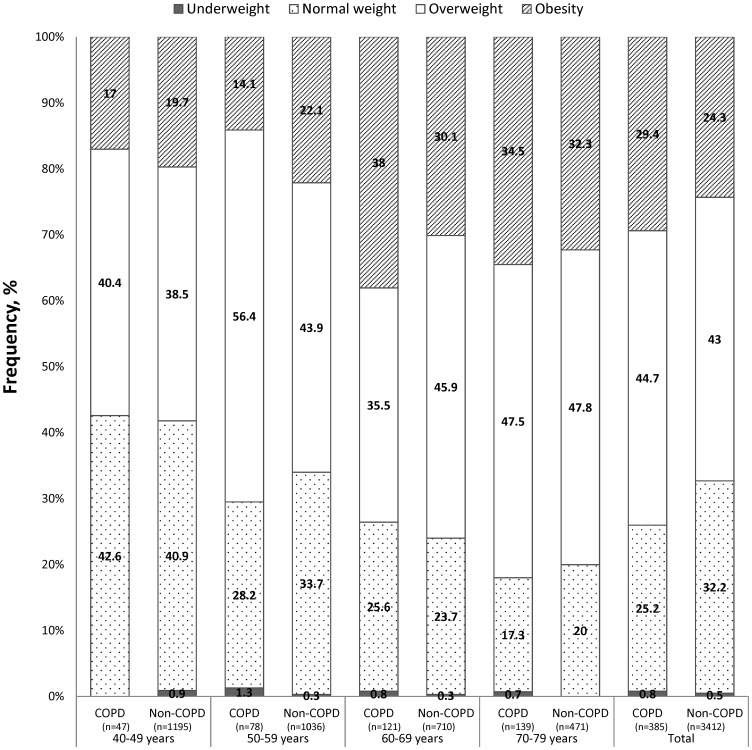
Distribution of BMI classifications according to age group in COPD and non-COPD subjects.